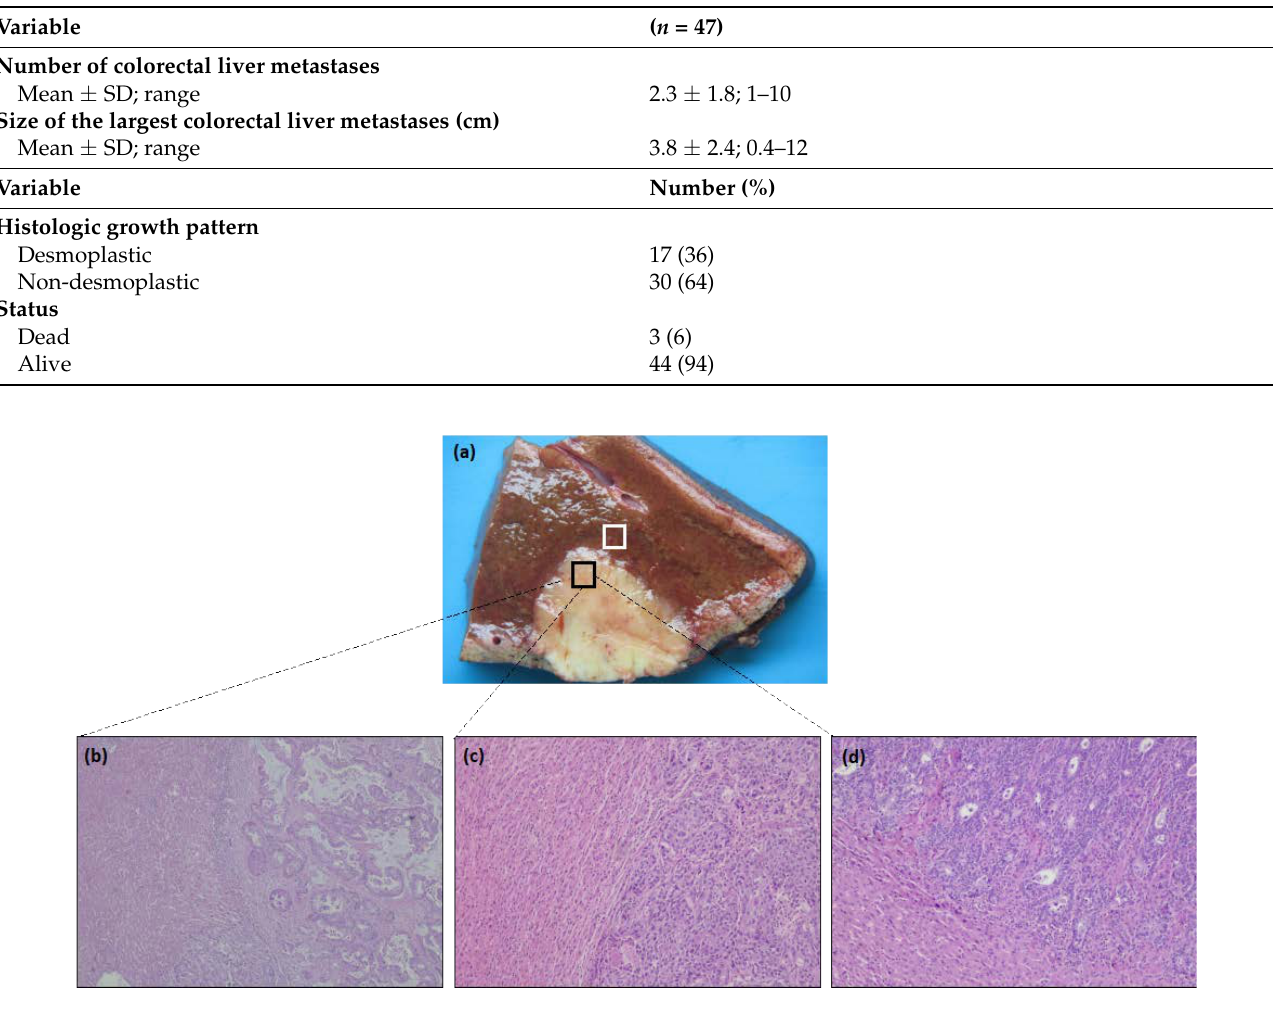
Figure 1. Liver gross section with colorectal metastases and representative histological images of the growth pattern of liver metastasis of CRC. ( a ) Tissue was collected at the tumor/non-tumoral interface, according to the picture—tumor (black) and non-tumoral (white). ( b ) Representative images of the immunohistochemistry-stained tumor sections with desmoplastic growth pattern (H&E 20×), ( c ) expansive growth pattern (H&E 40×), and ( d ) replacement growth pattern (H&E 40×).